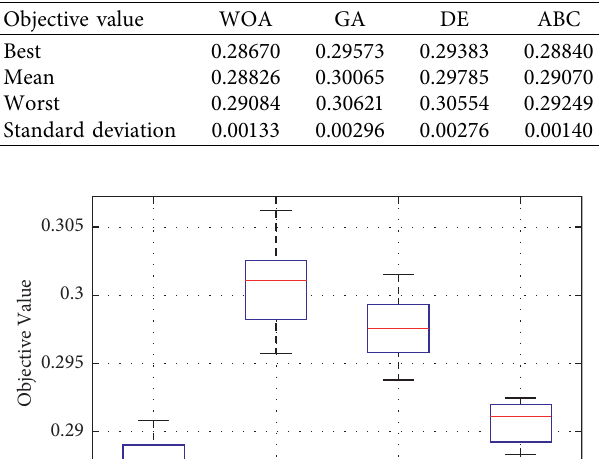
Figure 11: Convergence curves of the best solutions obtained with different meta-heuristic algorithms. Table 3: Performance comparison among different algorithms.